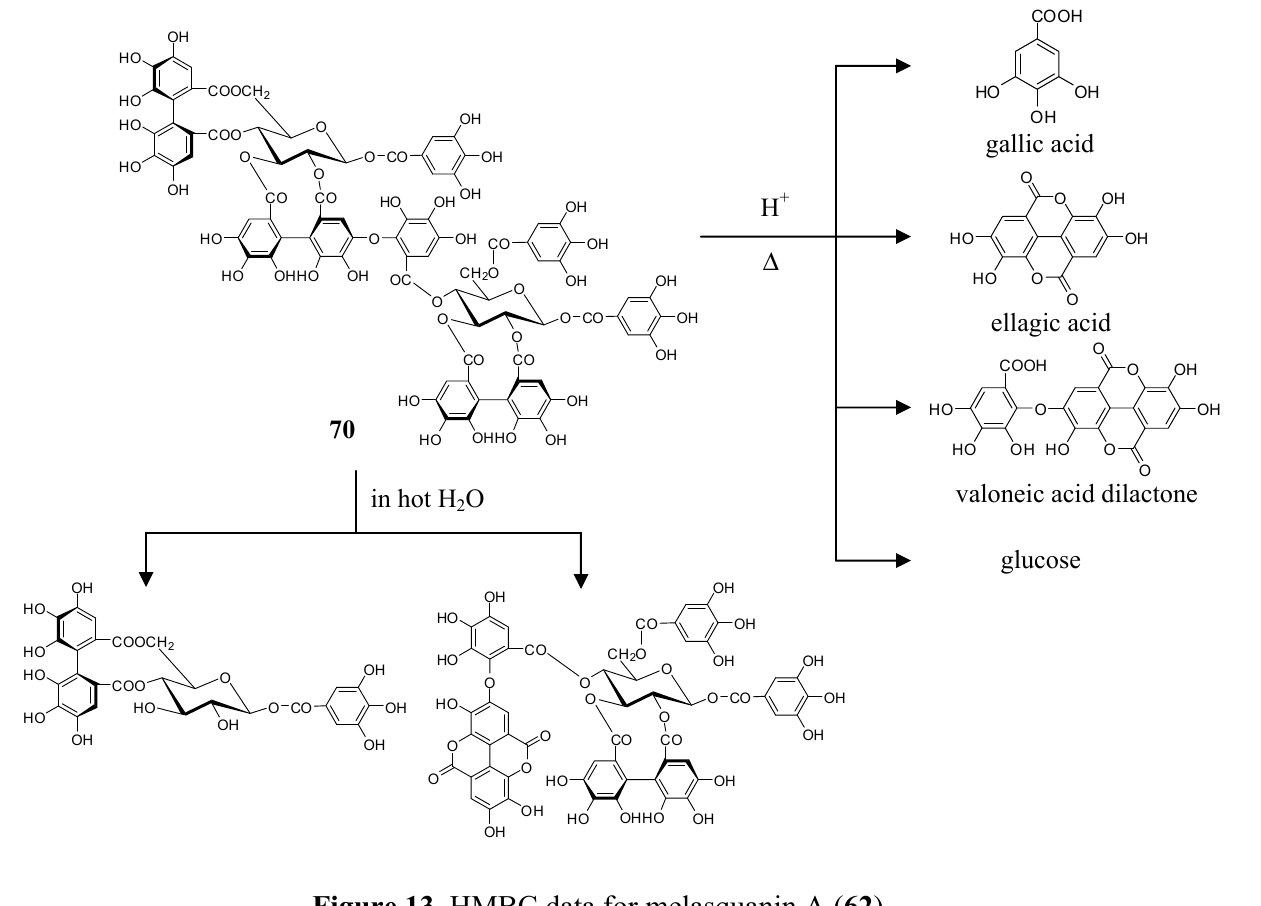
Figure 12. Chemical degradation of nobotanin B ( 70 ).